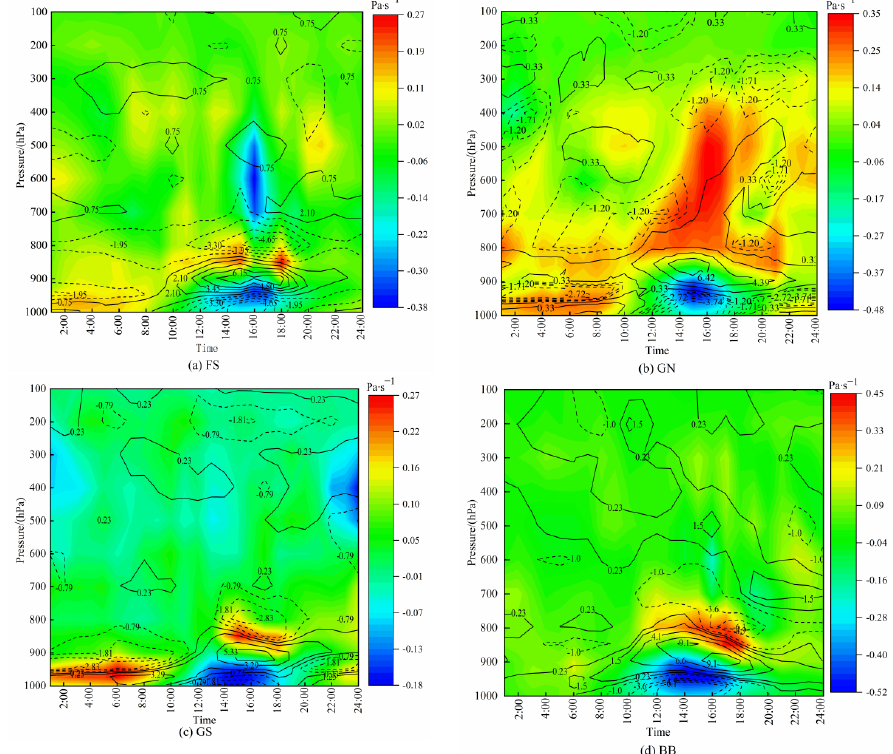
Figure 4. Vertical velocity (the shaded, unit: Pa s − 1 ) and divergence (black line, the dotted lines mean convergence and solid lines mean divergence, unit: 10 s − 5 ) at different pressure levels for each SWP.( a ) Warm sector ahead of front—Type FS; ( b ) cold high-pressure ridge—Type GN; ( c ) transformed surface cold high—Type GS; ( d ) edge of subtropical high pressure—Type BB.